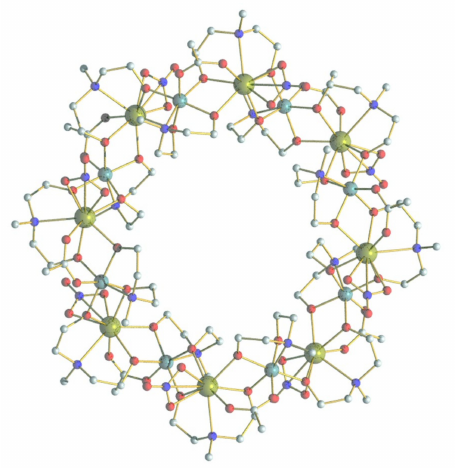
Figure 1. The molecular structure of {Cr 8 Y 8 }. Cr cyan, Y dark yellow, C grey, N blue, and O red. The hydrogen atoms are omitted for